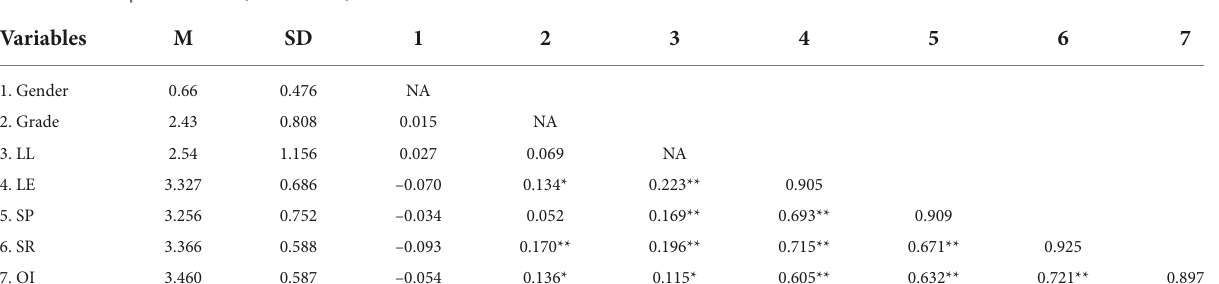
TABLE 1 Descriptive statistics, correlation, and reliabilities for all variables.